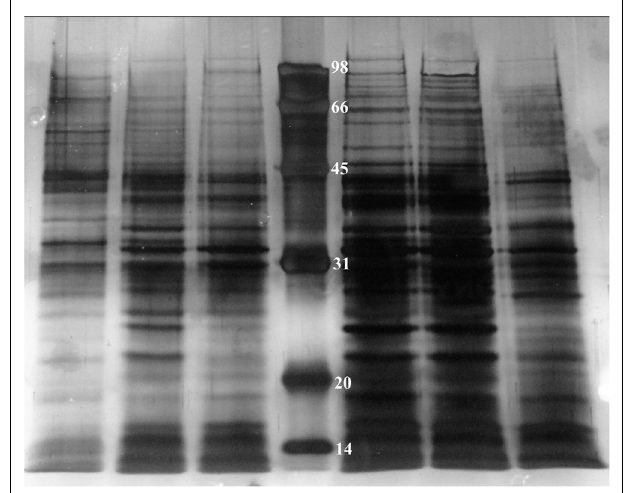
FIGURE 5 | 1D SDS-PAGE of cytoplasmic proteins obtained from A. avenae subsp. avenae cells. Lane 1–3, wild-type strain RS-1 under no stress conditions, 0.4 mM paraquat and 40 mM H 2 O 2 stress conditions, respectively; Lane 4–6, mutant strain RS- tetR under 0.8 mM paraquat, 60 mM H 2 O 2 stress conditions and no stress conditions,